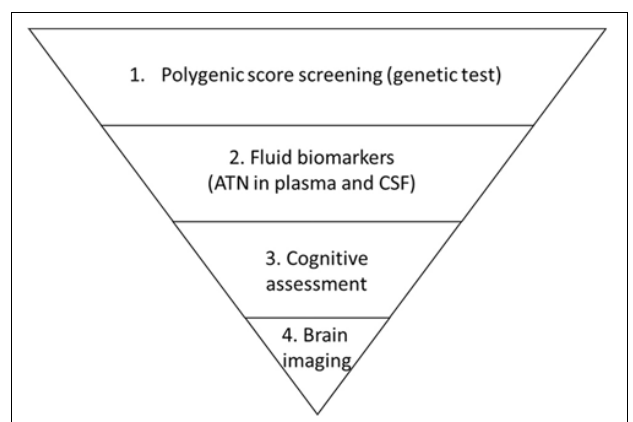
FIGURE 2 | Proposed hierarchal strategy for Alzheimer’s disease risk screening. Individuals enrolled in a screening task are first examined according to genetic risk as indicated by polygenic risk analysis. Individuals who have relatively high risk and report symptoms are referred for biomarker examination to evaluate amyloid-beta, tau (and p-tau), and neurofilament light polypeptide levels (i.e., the “ATN” panel) in blood or cerebrospinal fluid (CSF). Those who exhibit altered levels of biomarkers are further referred to clinicians for cognitive assessment followed by brain imaging including magnetic resonance imaging and positron emission